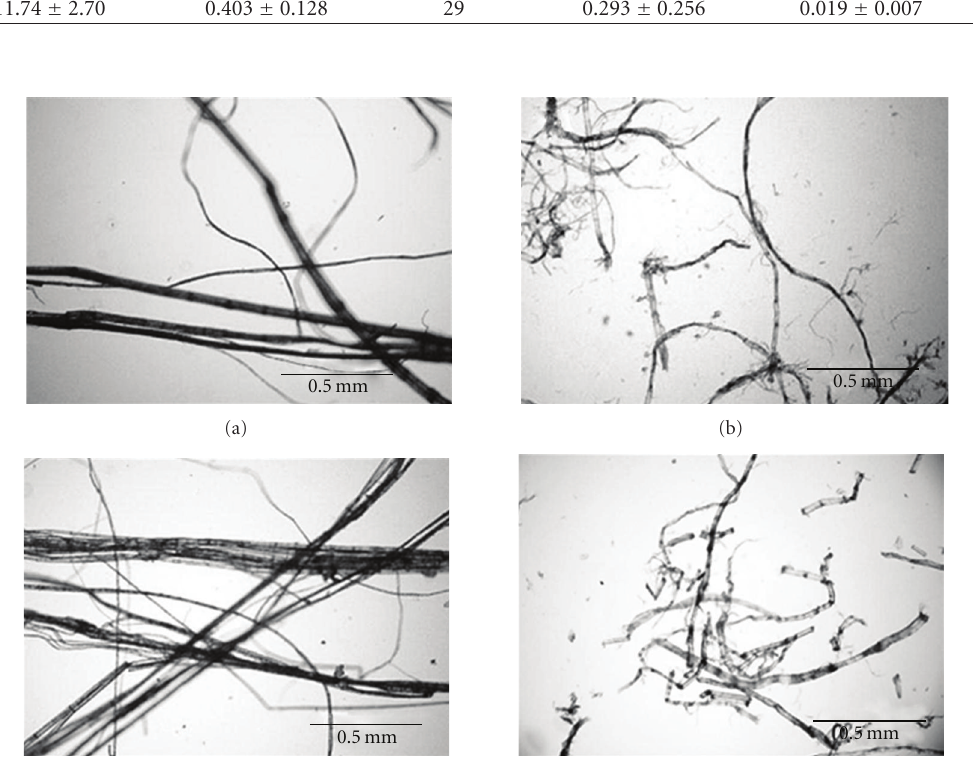
Figure 4: Optical microscopy images of hemp and flax fibers: (a) unprocessed (b) and fully processed hemp fibers; (c) unprocessed and (d) fully processed flax fibers.